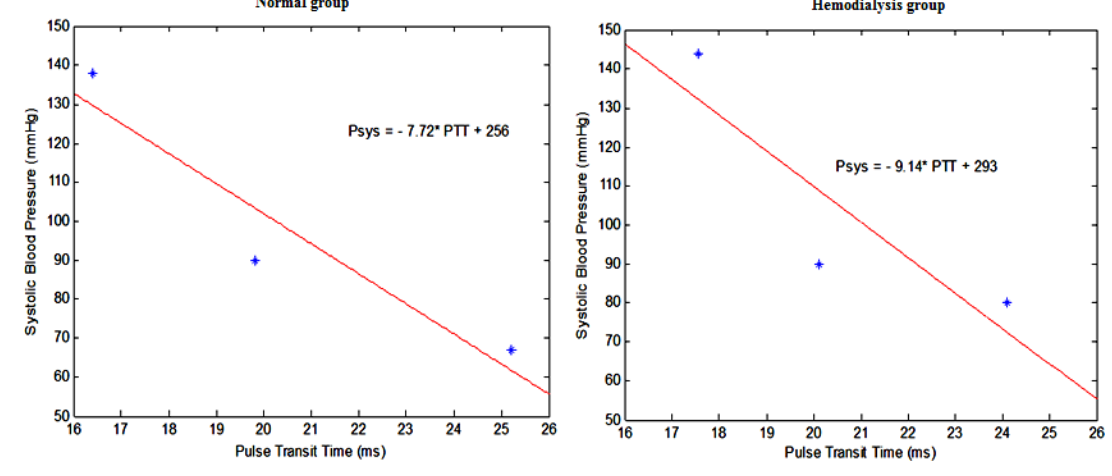
Fig. 2. Linear function for the set of data pairs in calibration